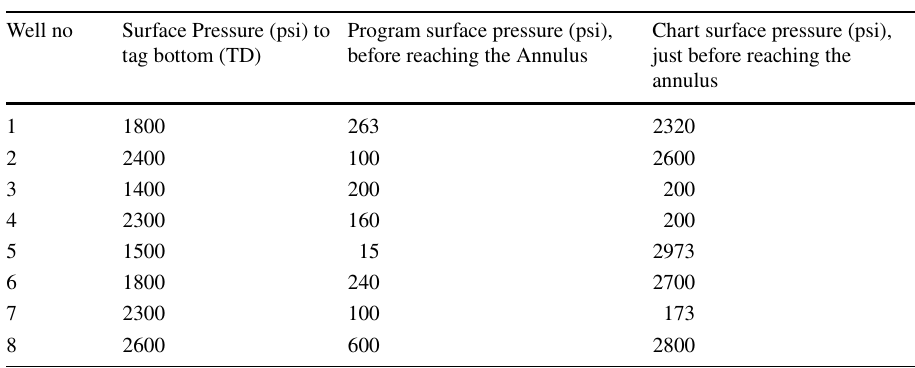
Well no Surface Pressure (psi) to Program surface pressure (psi), tag bottom (TD) before reaching the Annulus